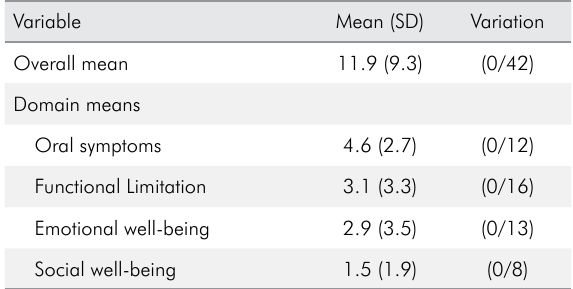
Table 2. Child Perception Questionnaire 11-14 (short form)